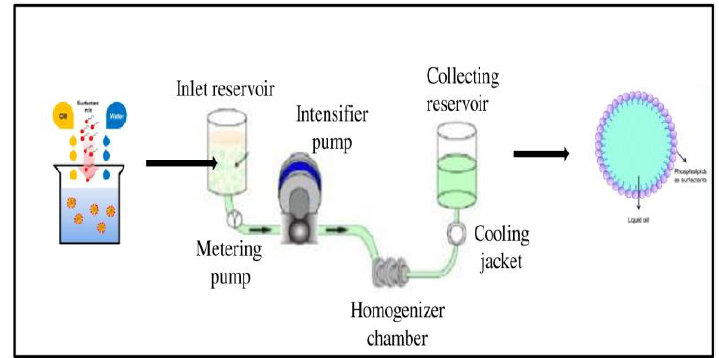
Figure 7. Preparation of nanoemulsion of vitamin A and C using Lipoid S75 and microfluidization.